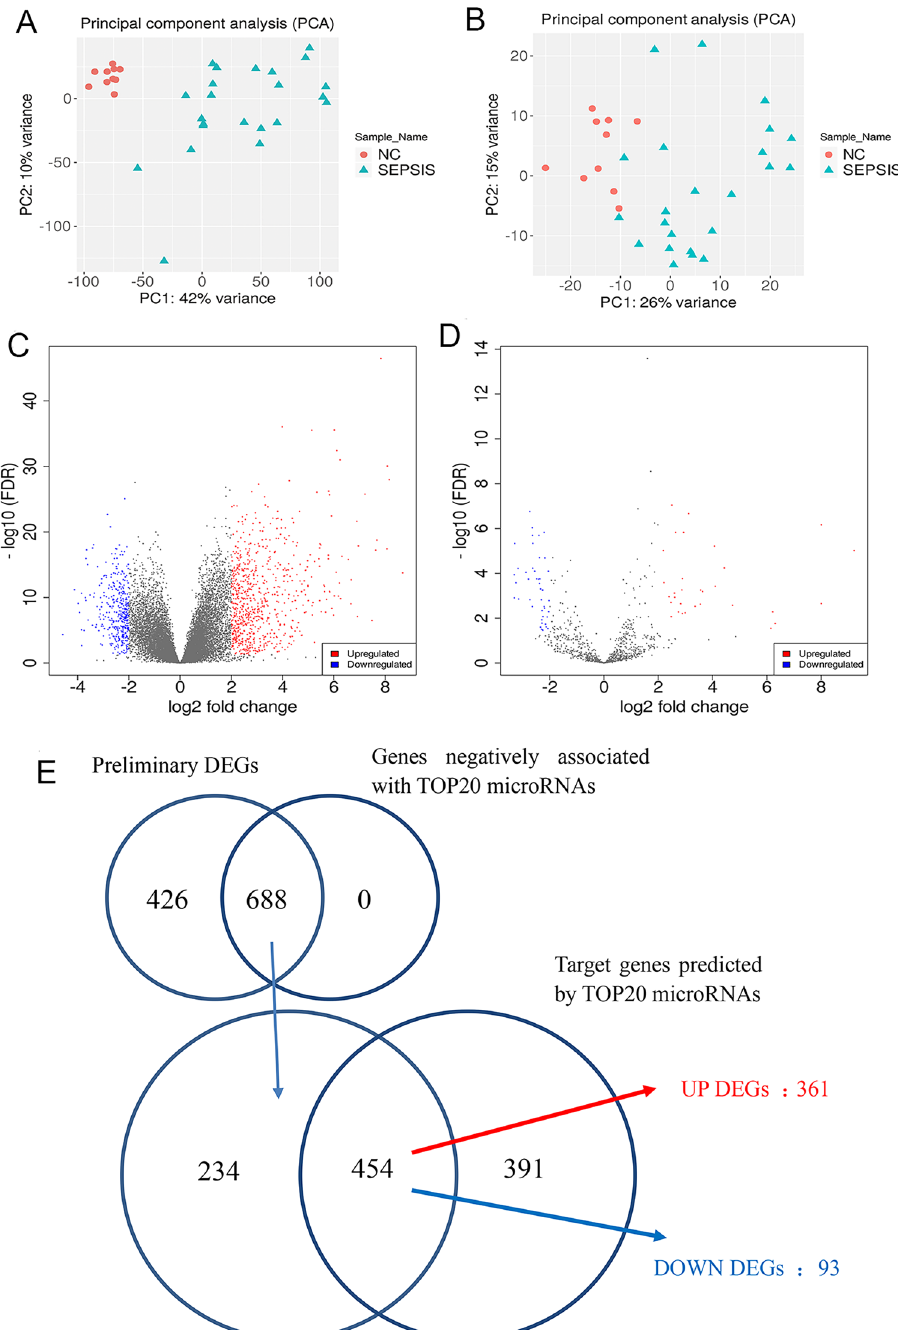
Figure 2. Bioinformatics analysis of RNA-seq data. ( A ) PCA of mRNAs. ( B ) PCA of microRNAs. Both panel A and panel B show that there was good consistency within the groups and a significant difference between the groups. ( C ) Volcano plot of mRNAs. ( D ) Volcano plot of miRNAs. ( E ) A workflow for screening DEGs. Red nodes, upregulated genes or miRNAs in sepsis; blue nodes, downregulated genes or miRNAs; gray nodes, genes or miRNAs with no considerable difference between the sepsis group and the NC group. Log2 fold change (log2FC) = 2, FDR < 0.05. NC the healthy control group, SEPSIS the sepsis group, FDR false discovery